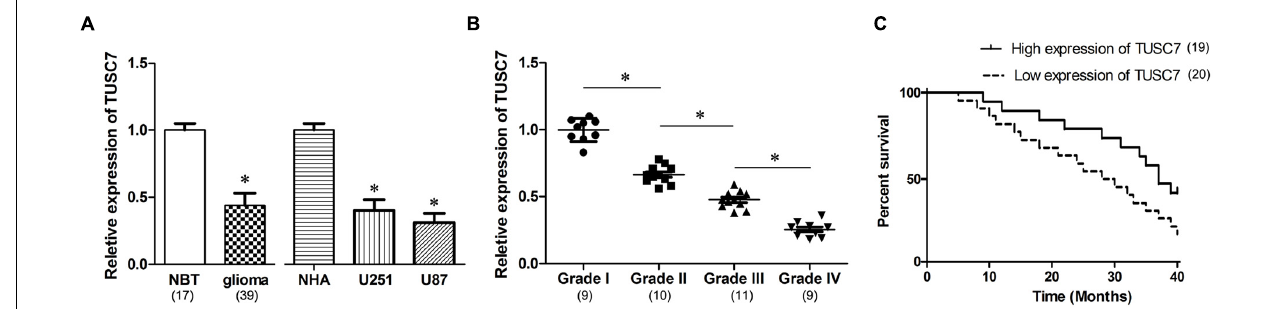
FIGURE 2 | (A) Compared with normal brain tissues (NBT) and normal human astrocytes (NHA) cells, TUSC7 was poorly expressed in human glioma tissues and cell lines. (B) Glioma tissues with worse histological grade exhibited decreased TUSC7 expression. (C) Kaplan–Meier analysis indicated that lower TUSC7 expression was associated with a significantly shorter survival time than higher TUSC7 expression. Data are presented as mean ± SD ( n = 5, each group). ∗ P < 0.05 vs. NBT or NHA group.